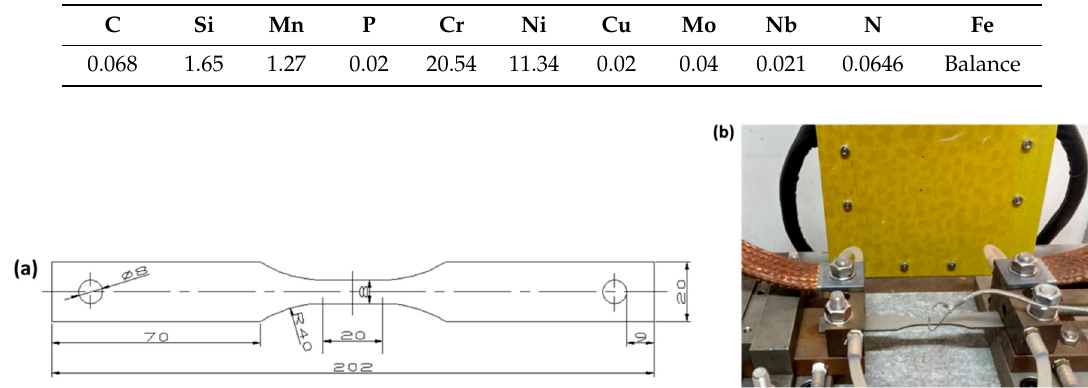
Table 1. Chemical composition of type 309 austenitic stainless steel (wt.%).